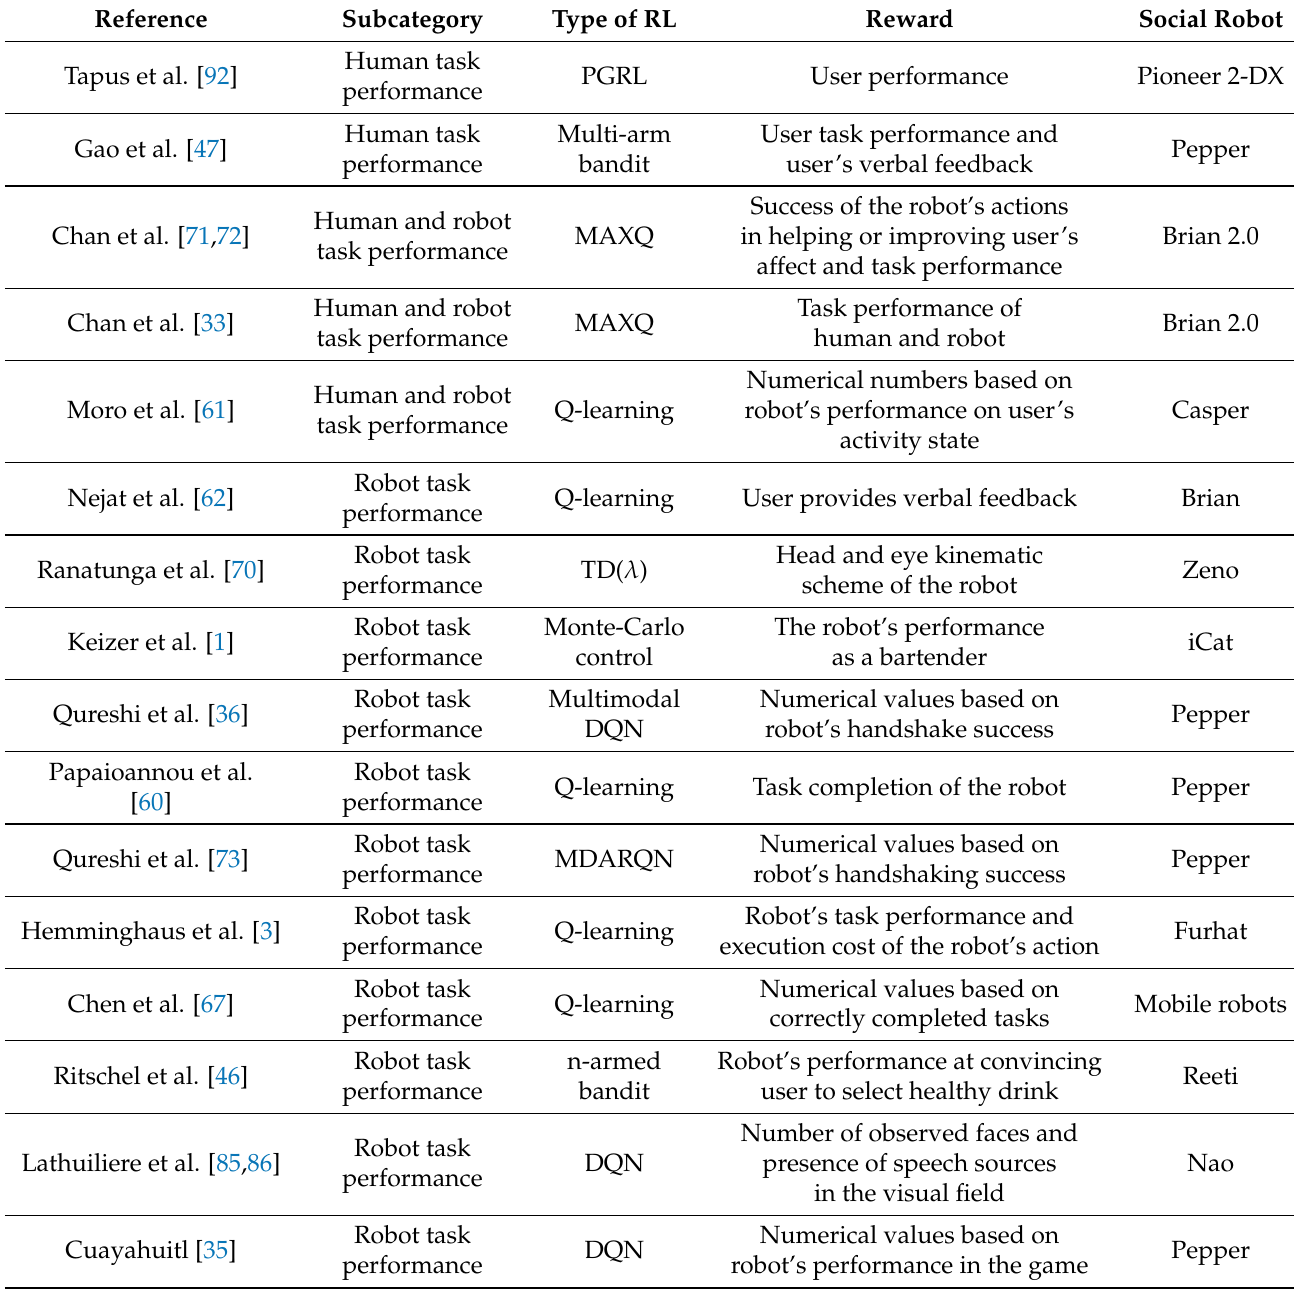
Table 3. Summary of Task performance driven methods in social